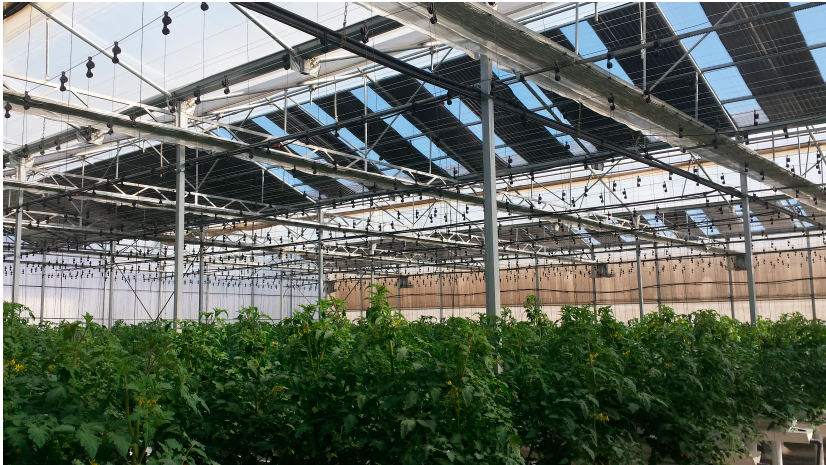
Figure 3. PV panels mounted on greenhouse roof. TECNOVA foundation experimental PV greenhouse (Almería).